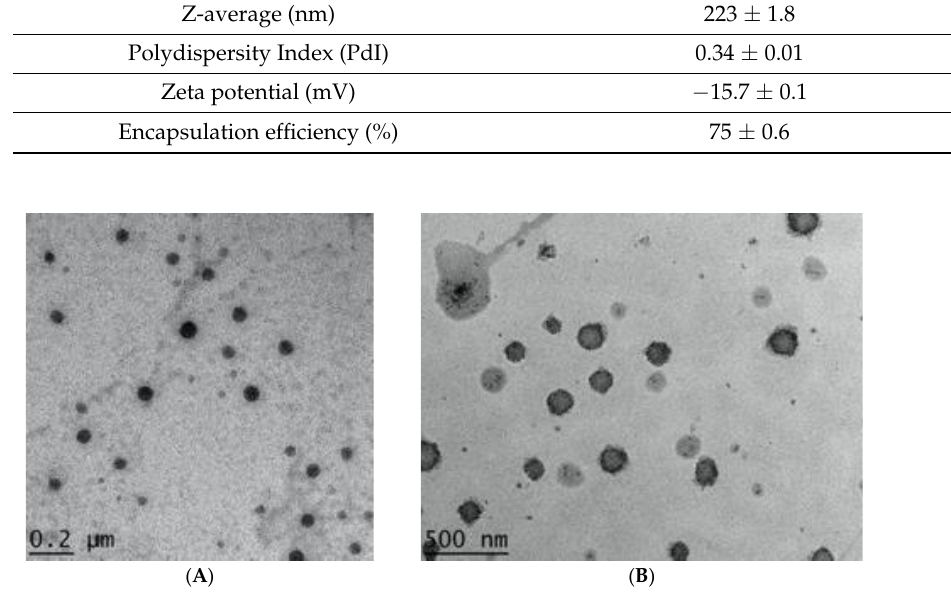
Figure 6. TEM images showing ( A ) blank LCNs and ( B ) optimized BP-LCNs. Table 4. Characterization parameters of BP-LCNs.